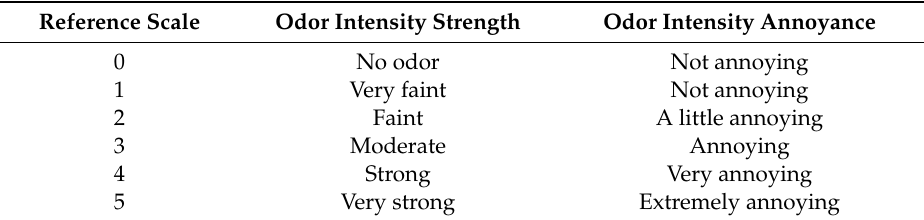
Table 1. Odor intensity scale